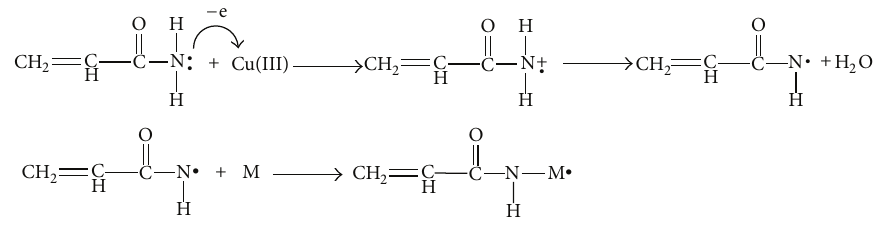
Figure 1: Scheme of initiating